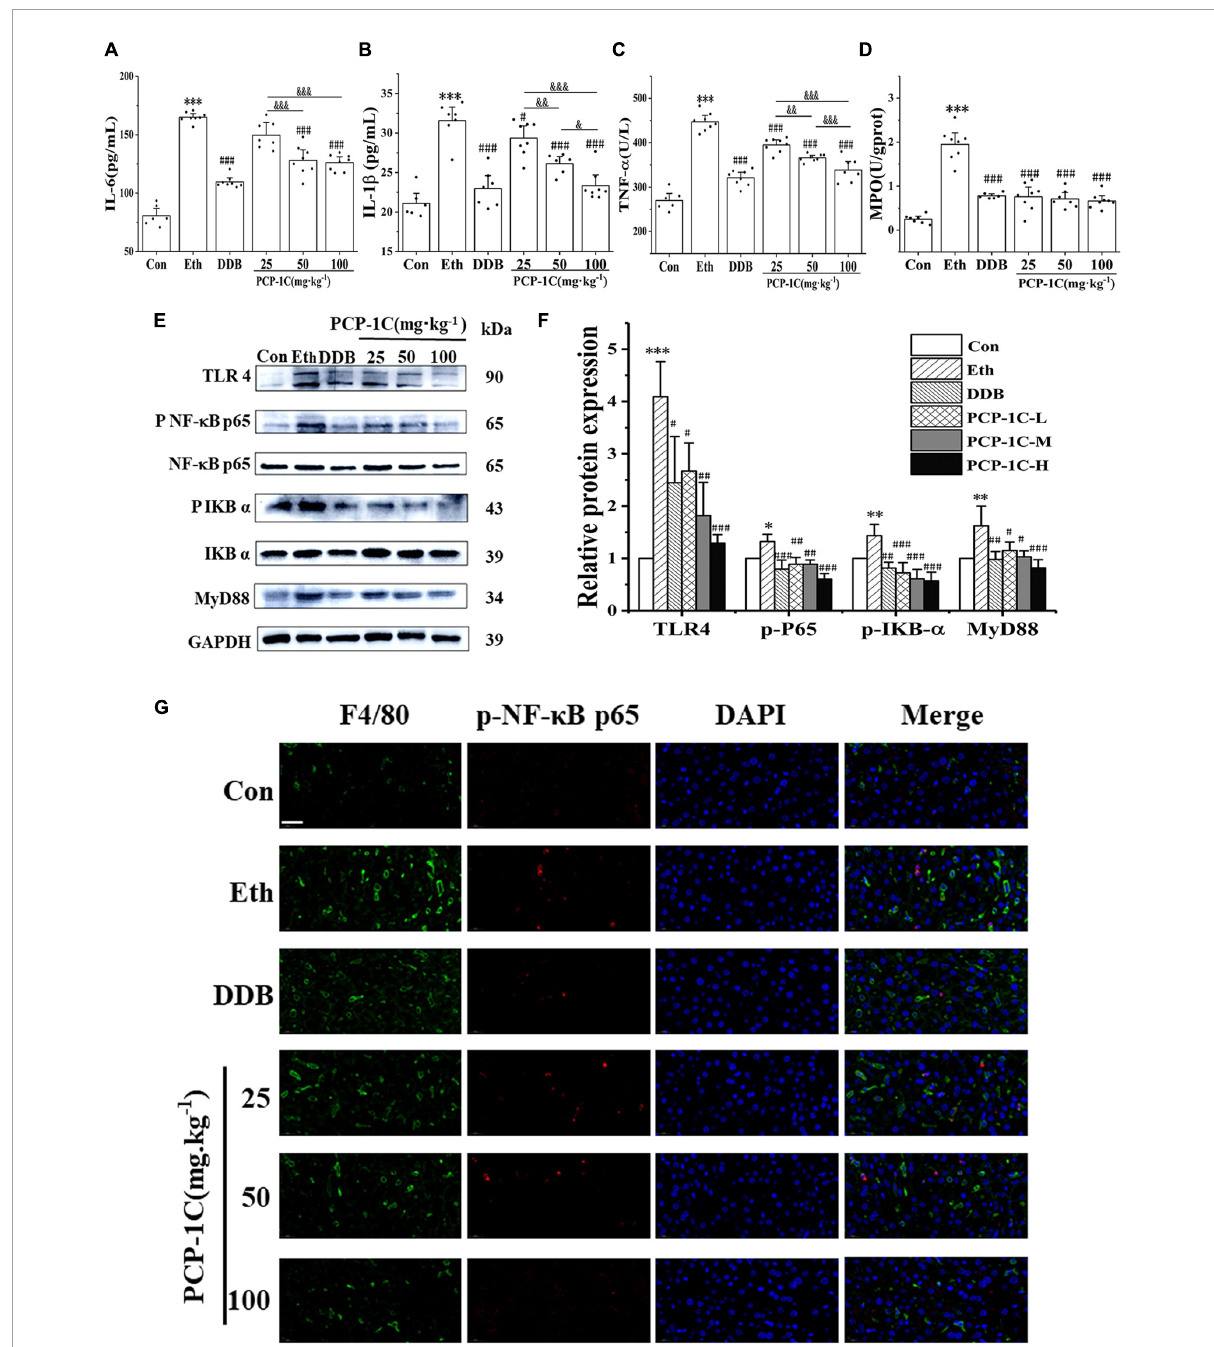
FIGURE3 Effects of PCP-1C on inflammatory cytokines and related protein expression in ALD mice. (A) The serum levels of IL-6, (B) IL-1ß, (C) TNF- α , and (D) hepatic MPO levels. (E) Representative immunoblot images of TLR4/NF- κ B related protein in liver tissue. (F) Relative protein levels and quantification of TLR4/NF- κ B related proteins. (G) Immunofluorescence staining of liver tissue. (Green: F4/80, red: p-NF- κ B p65, DAPI: The nucleus, × 400, scale 100 µ m). The results are presented as mean ± SD. ∗ P < 0.05, ∗∗ P < 0.01, ∗∗∗ P < 0.001 vs. the control group; # P < 0.05, ## P < 0.05, ### P < 0.001 vs. the model group. & P < 0.05, && P < 0.01, &&& P < 0.001 represents significance between PCP-1C